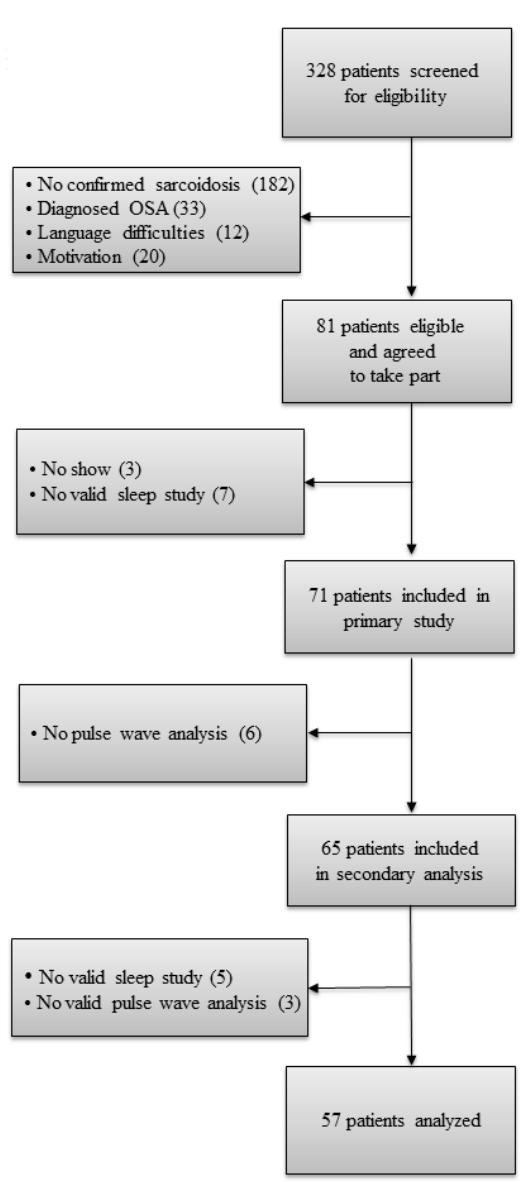
Figure 2. Study flow chart. Serum inflammation markers (CRP, Soluble interleukin 2 receptor (sIL-2R) and ne- opterin) and angiotensin converting enzyme (ACE) were not elevated. The median (quartiles) AHI and ODI were 3.8 (1.2/7.5) events/h and 5.3 (1.7/13.4) events/hour, re- spectively. Here, 23 (40%) sarcoidosis patients had at least mild OSA (AHI ≥ 5), while 7 (12%)patients showed an AHI ≥ 15/h. 3.2. Pulse Wave Analysis of Sarcoidosis Patients The mean (SD) Aortic AIx was 20.5 (8.6) %. Further parameters for the pulse wave are shown in Table 2.